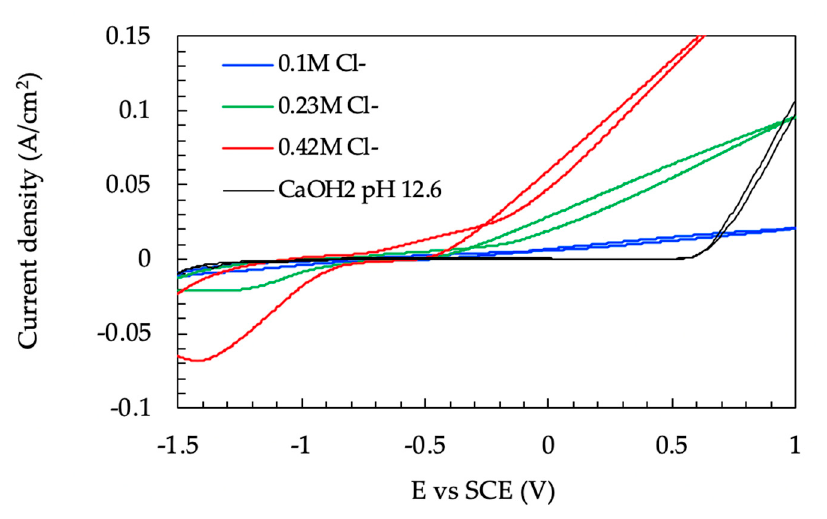
Figure 5. Effect of chloride ions on the second cycle of the voltammetric curves of steel in saturated Ca(OH) 2 solution at pH 12.7.